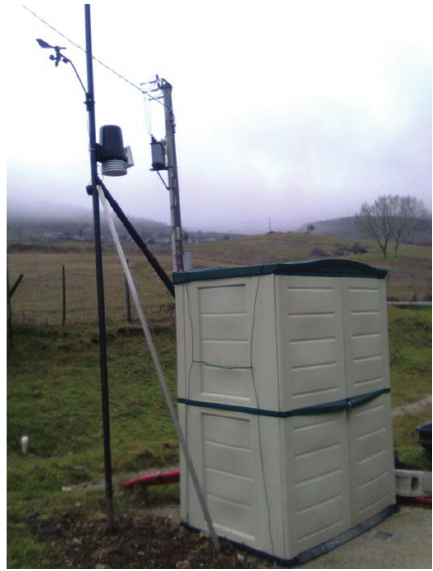
Figure 6: The weather station installed in the site.